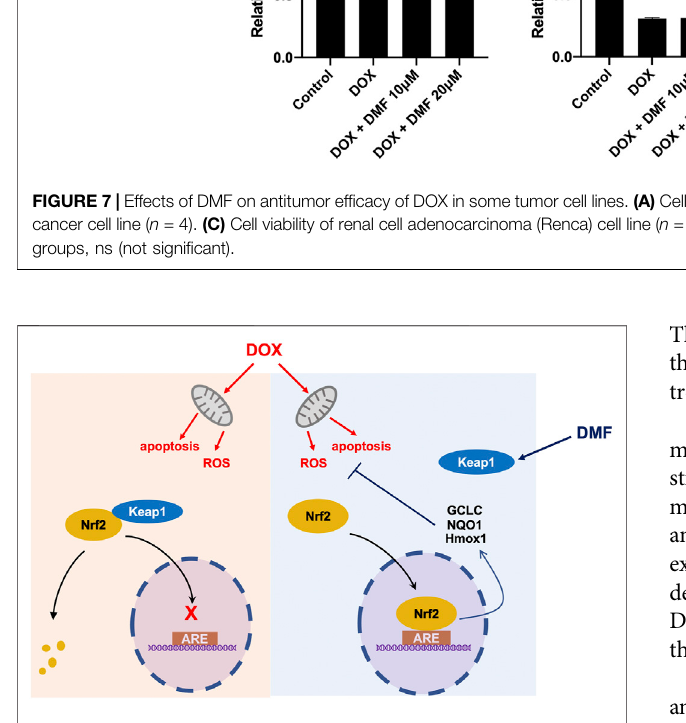
FIGURE 8 | A schematic diagram of protection of DMF against DOX- induced cardiotoxicity through Nrf2 pathway. ARE Antioxidant Response